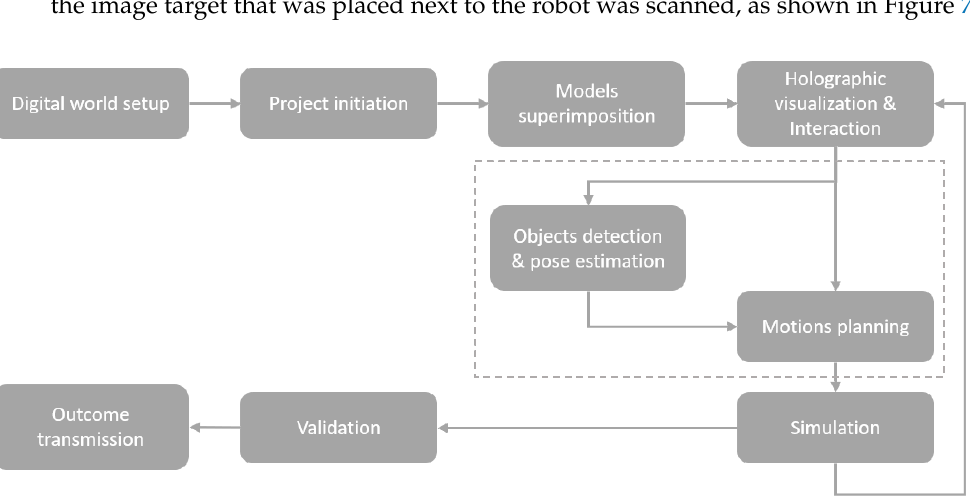
Figure 6. The MR framework phases, from project implementation to execution.